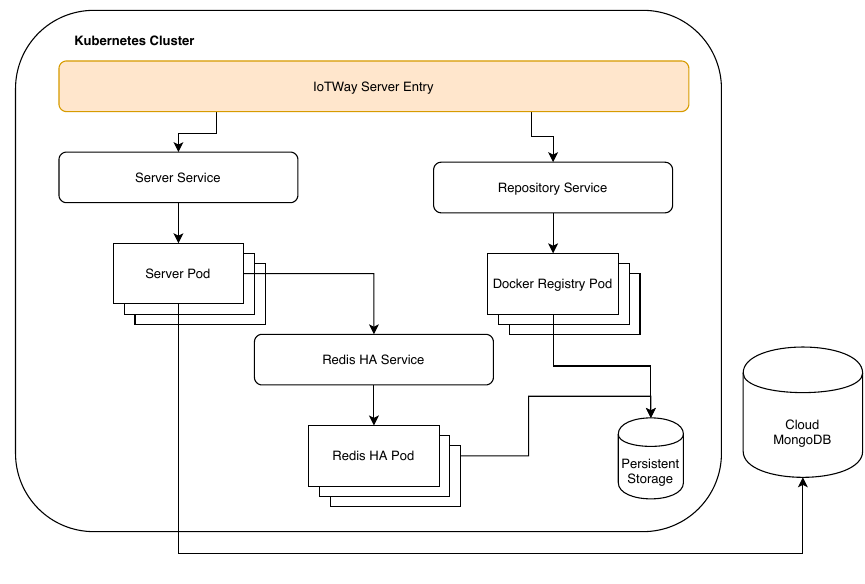
Figure 9. IoTWay server infrastructure.